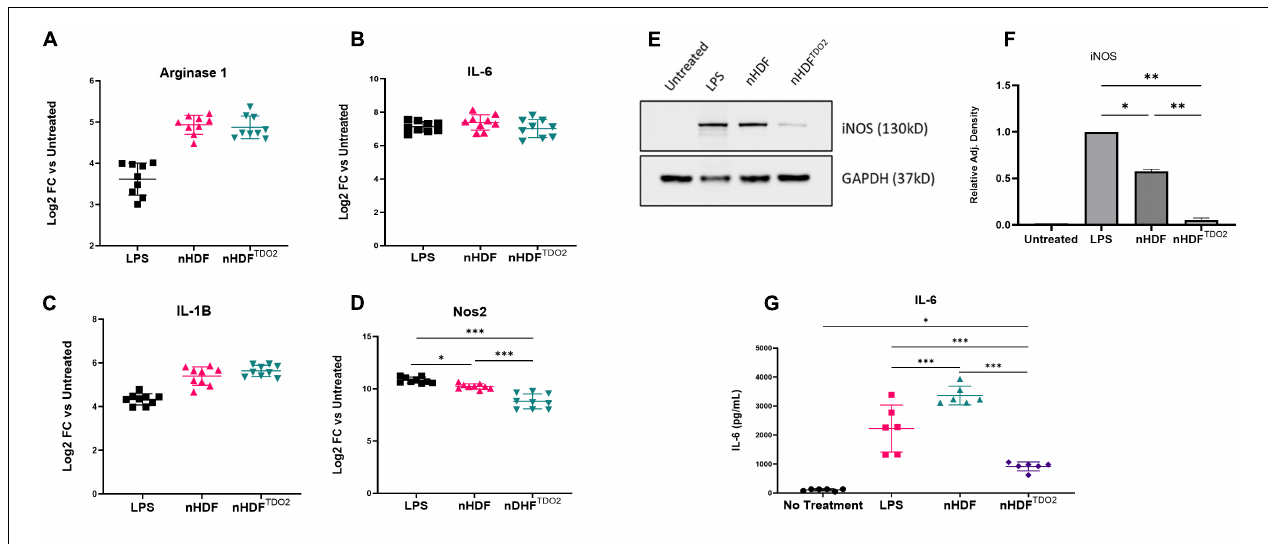
FIGURE 1 | Transwell co-culture of bone marrow-derived macrophages. (A–D) Gene expression of inflammatory genes after co-culturing of cells with nHDF or nHDF TDO2 cells ( n = 3 triplicates from three independent experiments). (E) Representative image of western blot detection of iNOS in BMDM lysates after overnight co-culture with nHDF or nHDF TDO2 cells and pooled data ( n = 2 biological replicates). (F) Analysis was done using one-way ANOVA with Sidak’s multiple comparison test. Error bars represent standard deviation. ∗ p < 0.05, ∗∗ p < 0.01, and ∗∗∗ p < 0.001.